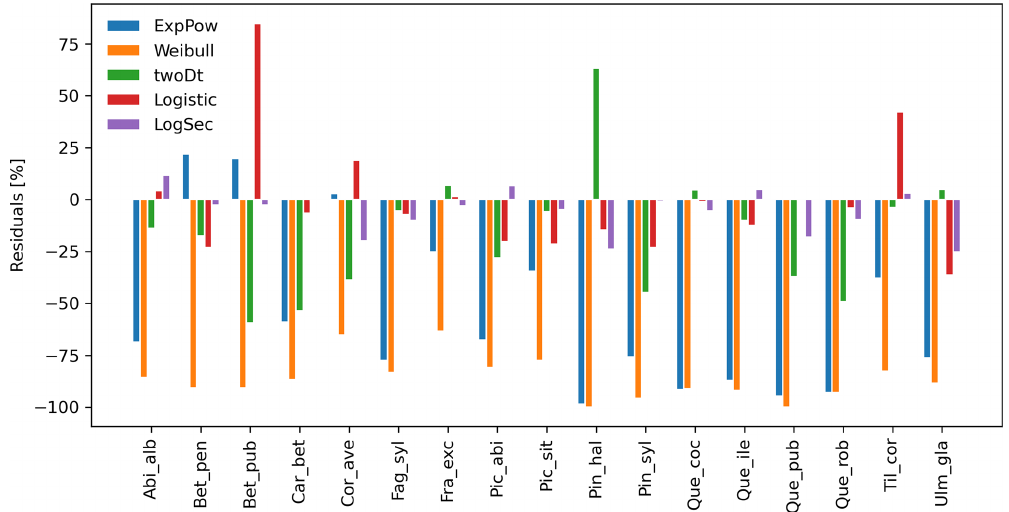
Figure 5. Performance evaluation of fat-tailed kernels. Comparison of species-specific residuals of observed versus simulated migration rates among newly implemented kernel functions. Observed values corresponds to the maximum of historical estimates (Table 1; Eq. 5).